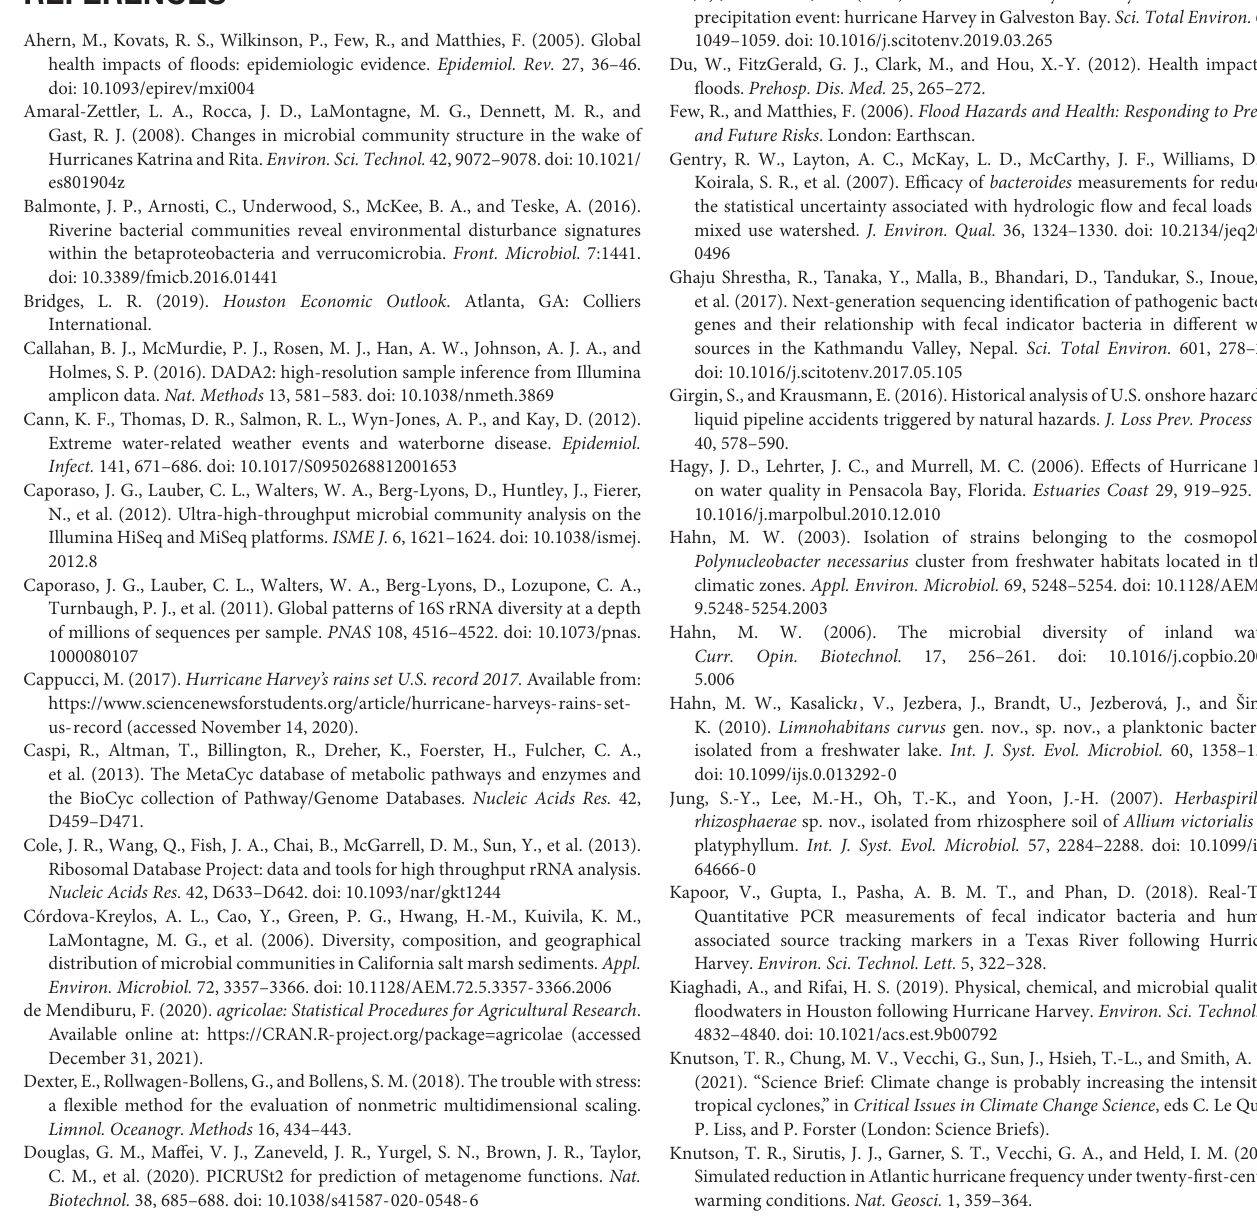
Supplementary Figure 9 | Microbial richness in Clear Lake system before and after Hurricane Harvey. X -axis indicates number of amplicon sequence variants. Categories correspond to before (pre), immediately after (HH) and more than a week after (post). Figure was generated with scripts in Supplementary File 5 . Supplementary Figure 10 | Rarefaction analysis of richness by number of reads. Symbols are as Figure 9 . Figure was generated with scripts in Supplementary File 5 . Supplementary Figure 11 | Shepards diagram showing fit of NMDS to dissimilarity of any two pairs of samples. Figure was generated with scripts in Supplementary File 8 . Supplementary Figure 12 | Fit of environmental data to NMDS model of microbial community structure. Stress value for model was 0.032, which suggests an excellent fit. Environmental variables that showed a significant ( P < 0.10)